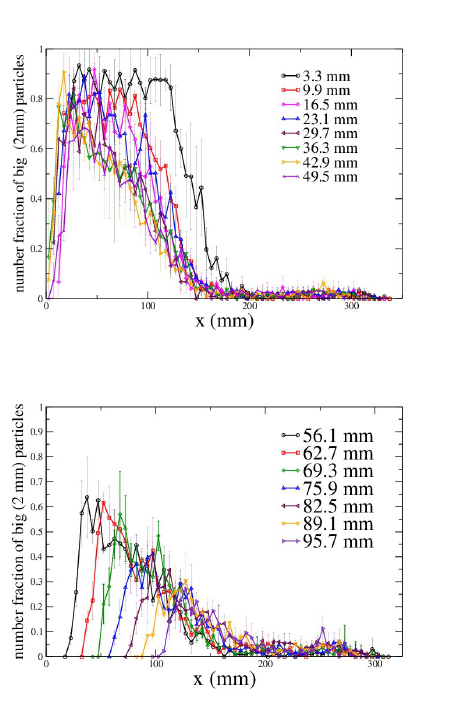
Figure 5. Profiles of number fraction of big particles (2mm) vs component x (mm) with depth y (mm) in layers for mixture of 50 % by volume of small (1mm) and 50 % by volume of big (2mm) particles: top layer & bottom layer for h = 22 cm & volume of pouring 100 g